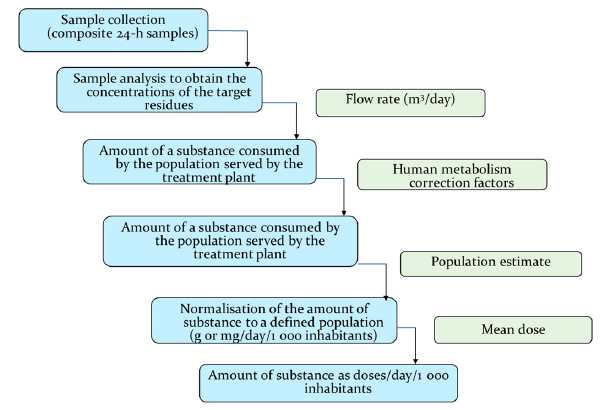
Figure 3: Wastewater analysis approach